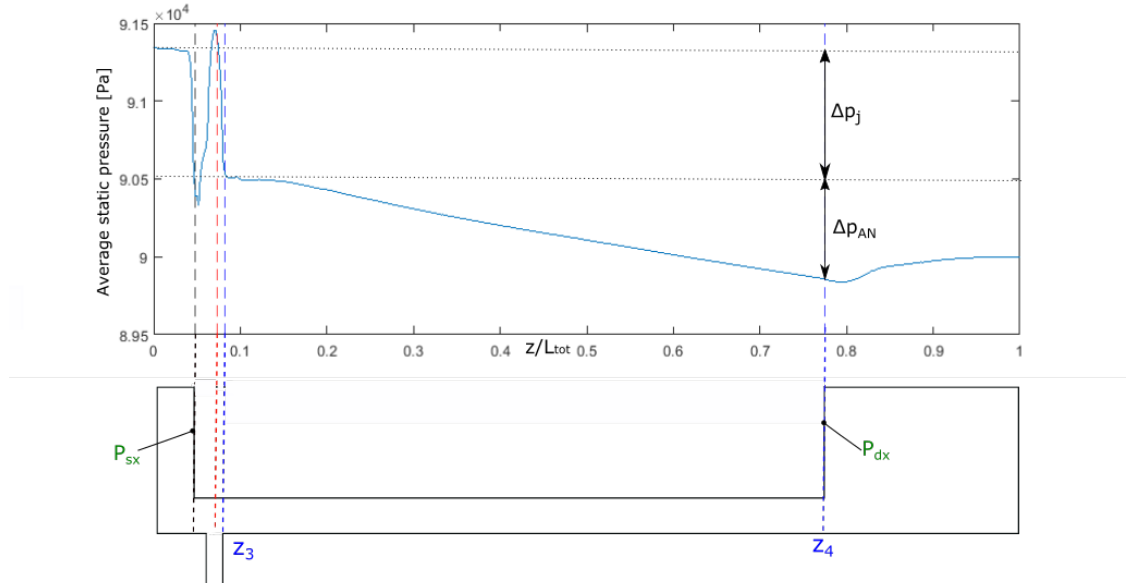
Figure 17. Average static pressure in the axial